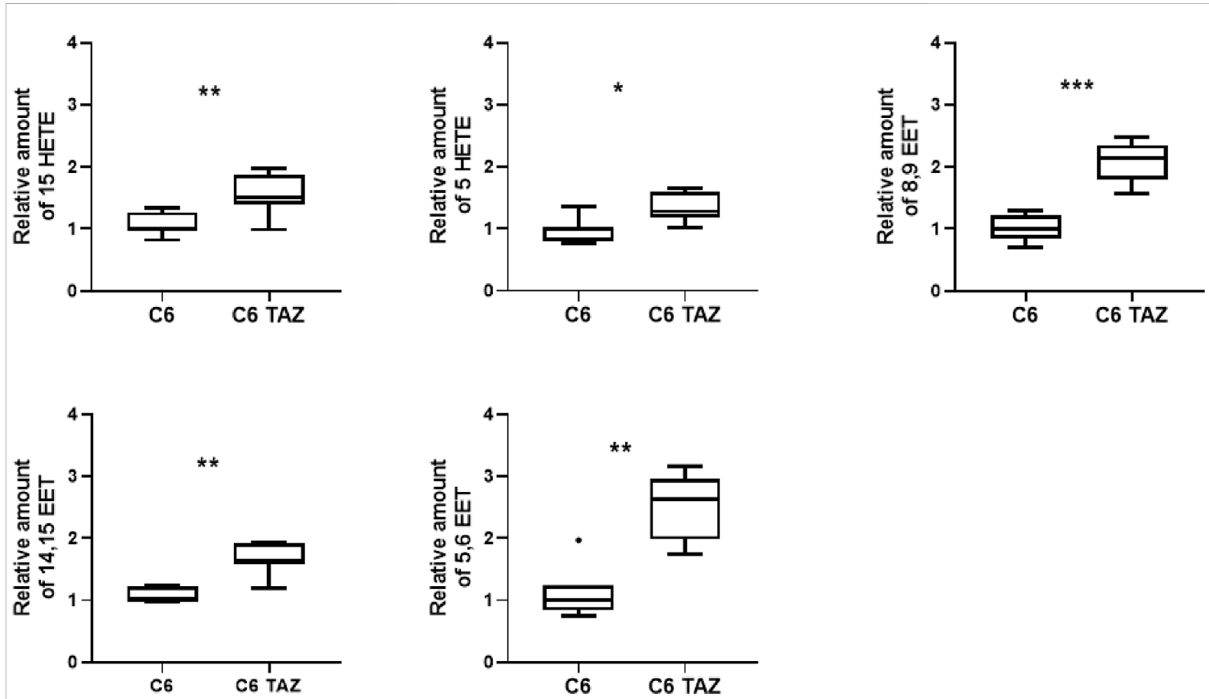
FIGURE 1 Tafazzinde fi ciencyaltersoxylipinlevelsinC6cells:Effectoftafazzinknockoutoncellularlipids,oxylipinswasdeterminedbyHPLC-MS/MS.The Data analysis was performed with Agilent Mass Hunter Qualitative and Quantitative Analysis software (version B.08.00 for both). For all detected oxylipins, a relative quanti fi cation was done by normalizing the area of the metabolite signal to the area of the signal of the internal